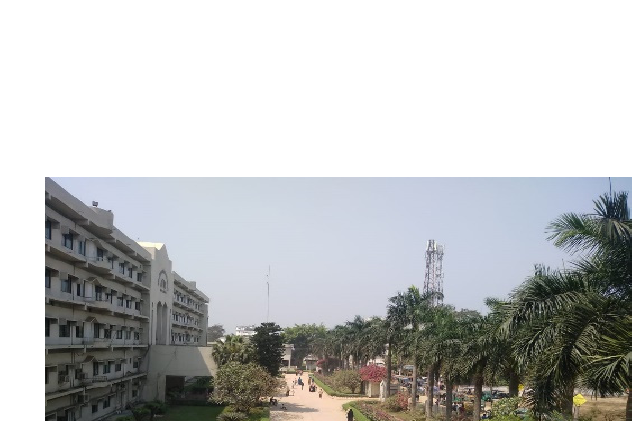
Figure 3. Alt-text: A view of a hospital courtyard with a garden, floral bushes and coconut trees.